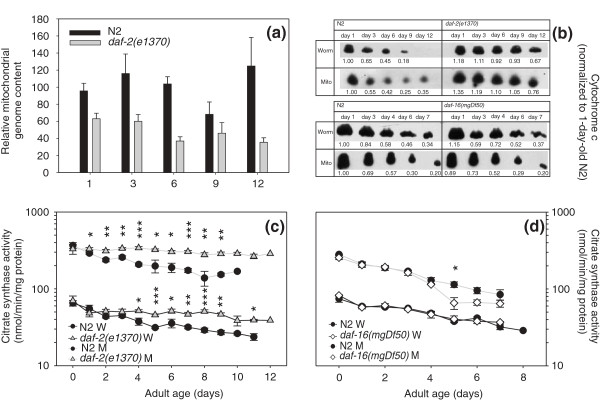
Effect of age on mitochondrial genome and cytochrome c content and citrate synthase activity. (a) Age-specific mitochondrial genome content of wild-type and daf-2(e1370) animals. Three mitochondrial genes were quantified; the results were normalized to obtain the relative mitochondrial genome content per strain and age cohort. The error bars indicate ± standard error of mean for three mitochondrial genes and three replicate ageing cohorts. (b) Western blots showing age-related changes of cytochrome c abundance in crude worm extract and isolated mitochondria. Results from one representative experiment are shown. The numeric values below each spot denote the abundance of cytochrome c in that spot normalized to the corresponding spot from 1-day-old wild-type (WT) adults. (c-d) Activity levels of citrate synthase in crude worm extract (indicated as 'W') and in isolated mitochondria (indicated as 'M'). Left panel: WT versus daf-2(e1370), right panel: WT versus daf-16(mgDf50). Data represent means ± standard error of mean (bars) for at least three replicate cultures; *, P < 0.05, **, P < 0.01, ***, P < 0.001.